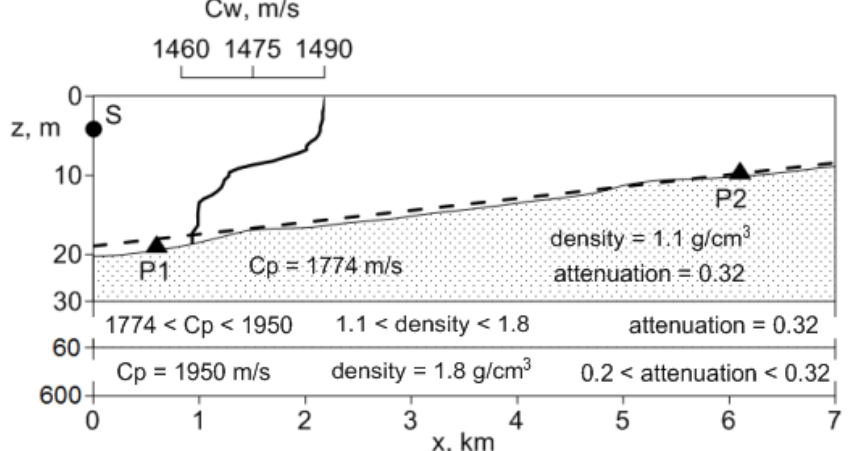
Figure 3. Waveguide model in the considered example, and the values of acoustic parameters of the